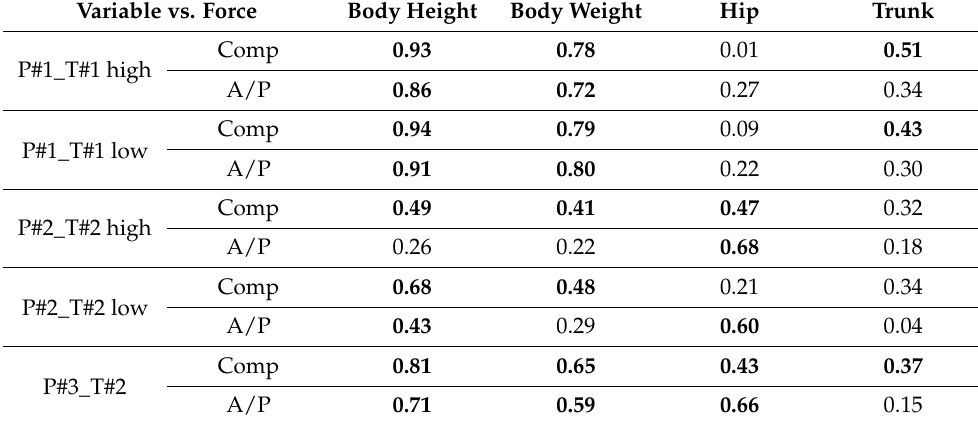
Table 4. The correlation coefficients for both compressive and A/P loads. Values greater than 0.35 are